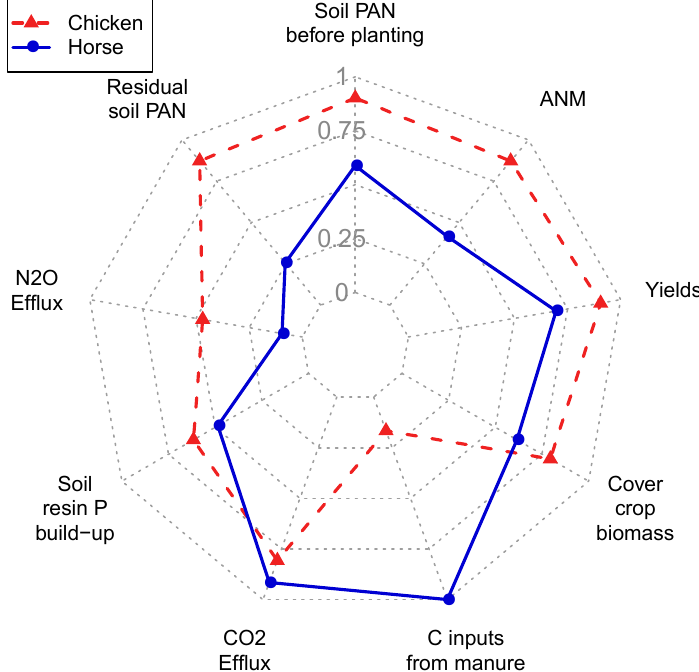
Figure 4. Radar plot displaying average values for each treatment scaled to the maximum values observed for each variable. All di ff erences were statistically significant ( p < 0.05; except for yields that were significant at p < 0.1 and resin P build-up that was not significant), although the di ff erence in C inputs was not testable. Shaded variables represent negative environmental impacts (i.e., smaller values indicate a more desirable outcome). C = carbon; N = nitrogen; PAN = estimated plant-available N; P = phosphorus; N 2 O = nitrous oxide; CO 2 = carbon dioxide; ANM = apparent net mineralization.